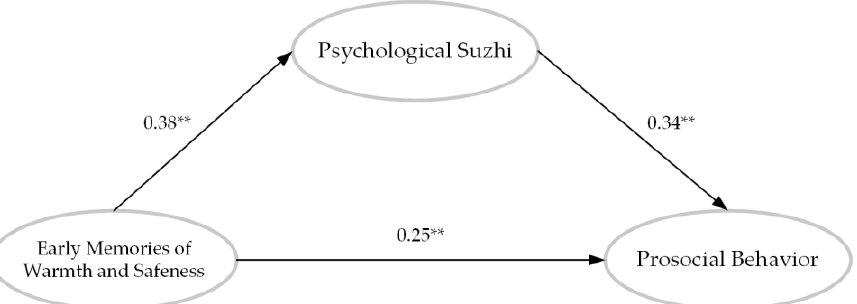
Figure 2. The mediation role of psychological suzhi in the relationship between EMWS and prosocial behavior. Notes . EMWS = early memories of warmth and safeness. ** p <